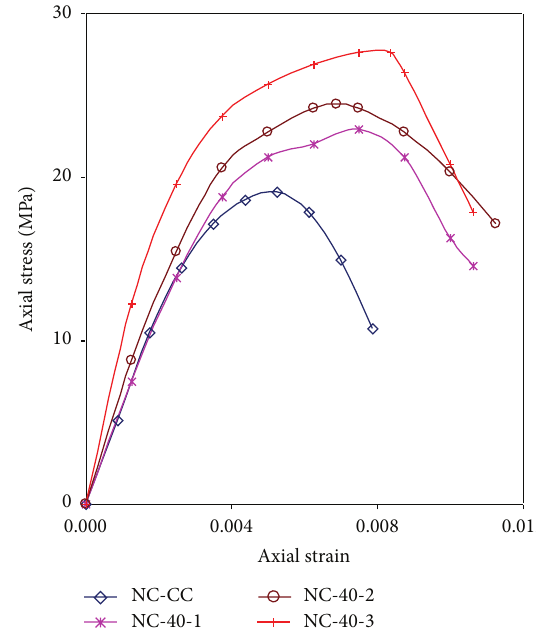
Figure 13: Axial stress-strain behaviour of columns confined with 40 mm spacing,